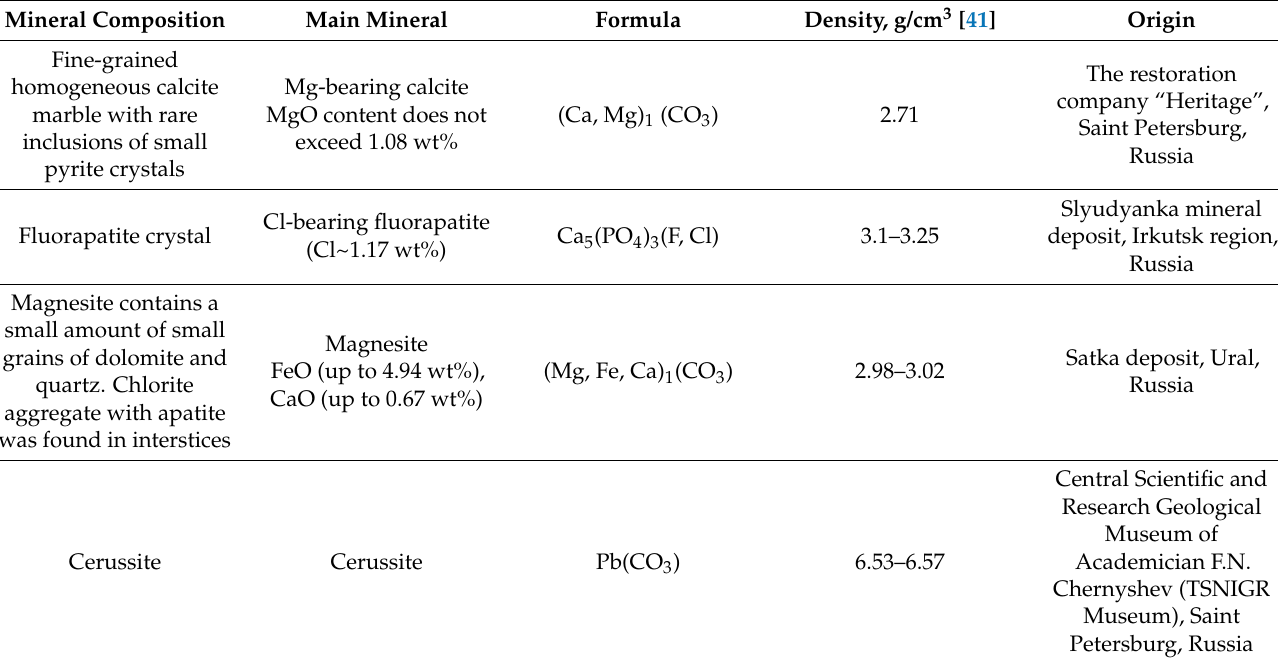
Table 3. Characterization of the underlying stone substrates used in model